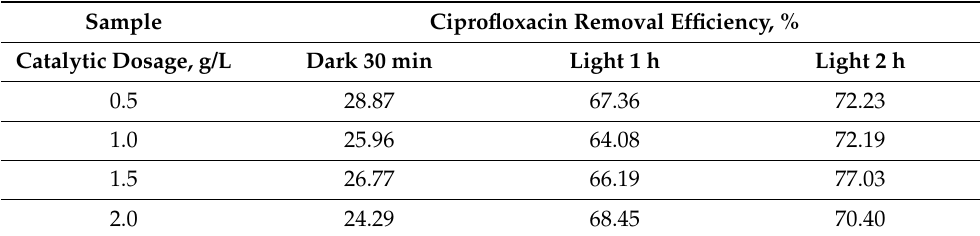
Figure 9. ( a ) The removal efficiency of CIP under the different ratios of BFO/biochar versus irradiation time. ( b ) The removal efficiency of CIP at different CBB dosages versus irradiation time. ( c ) The removal efficiency of CIP under different initial concentrations of CIP versus irradiation time. Table 2. The removal efficiency of CIP at different ratios of BFO/biochar. Table 3. The removal efficiency of CIP at different CBB dosages with respect to